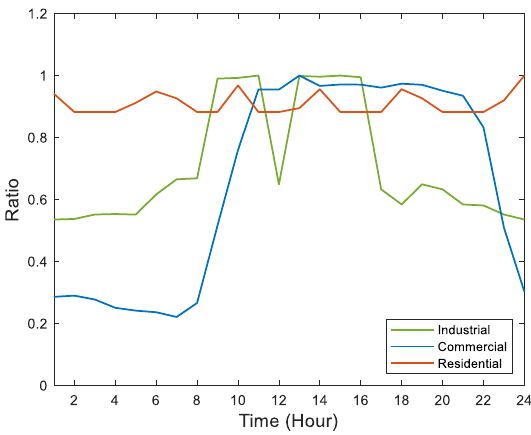
Figure 5. Normalized PV generation profile. Figure 4. Normalized load profiles by customer types on a selected day.